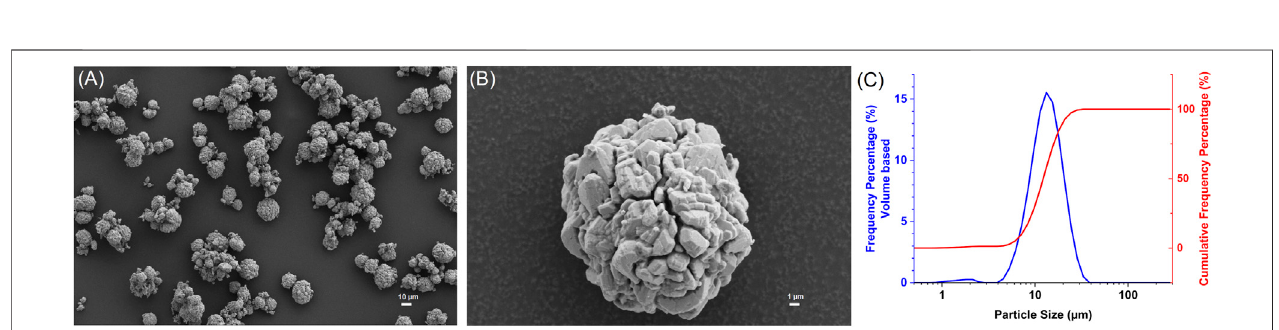
FIGURE 7 | SEM images at (A) low and (B) higher magni fi cation. (C) particle size distribution of P2- Na 0.64 Mn 3/4 Ni 1/4 O 2 material.